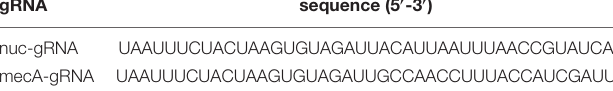
TABLE 1 | gRNA sequences for nuc and mecA